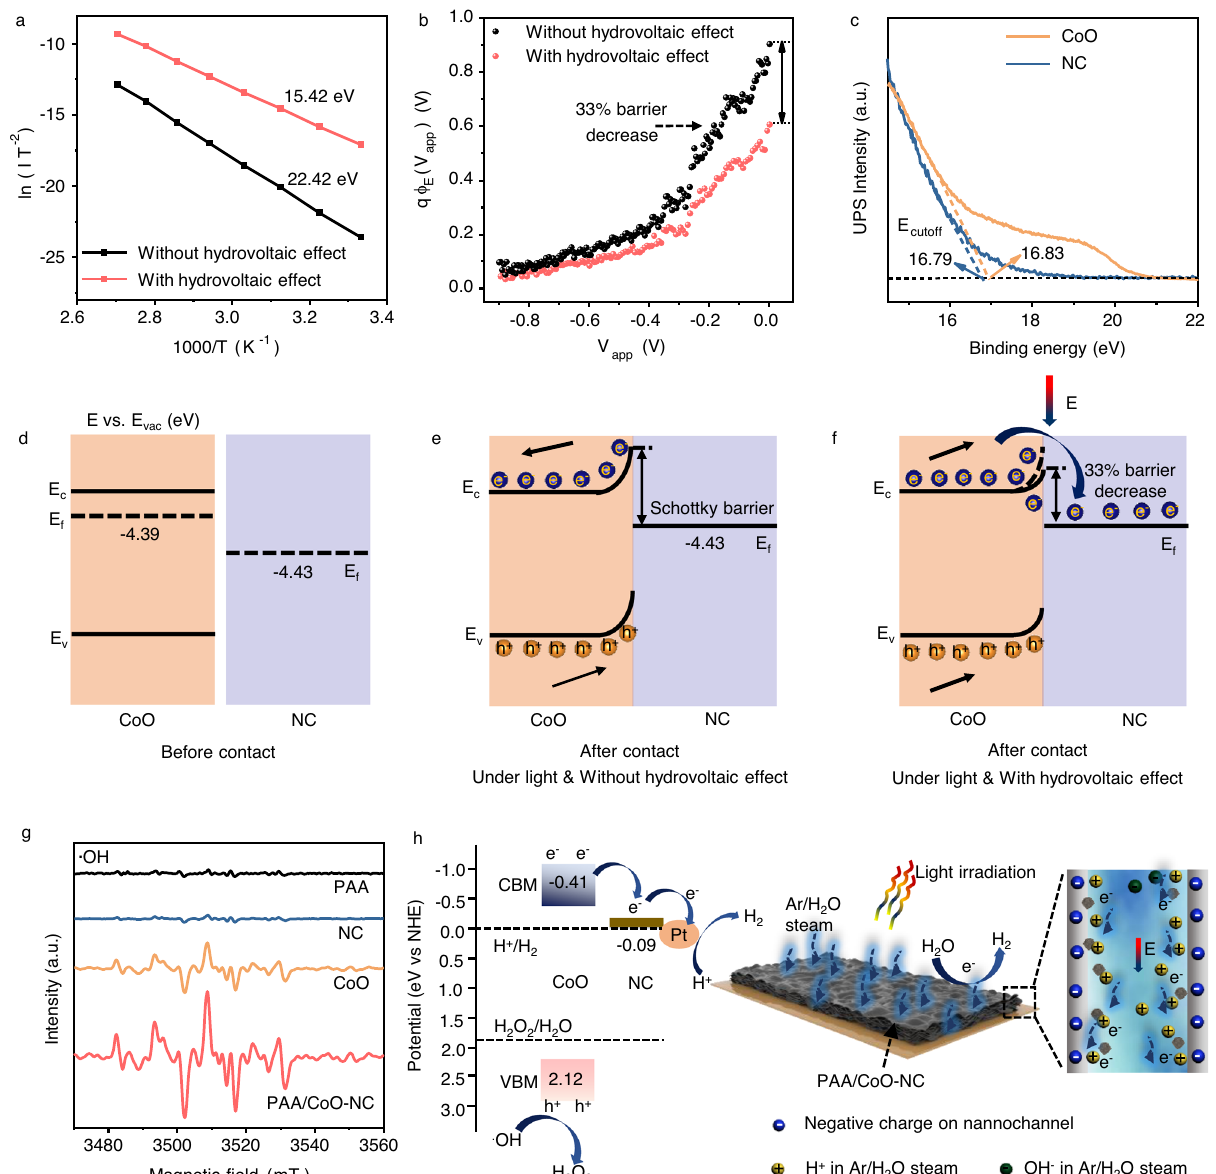
Fig. 5 | Photocatalytic mechanism of the hydrovoltaic effect-enhanced photo- catalysissystem.a ThemeasuredArrheniusplotsextractedfrom I – V curves; b The extracted effective energy barrier height q + E ð V app Þ with voltage dependence; Negative bias corresponds to a Schottky contact, indicating the observed large scattering near zerobias,and the dataofthe scattered point are measurable in the rangeofappliedbias; c UPSspectraofthecut-offregion(Secondarycut-offbinding energy: E cutoff ) for CoO and NC; d – f Band diagram mechanisms for equilibrium in theCoO –